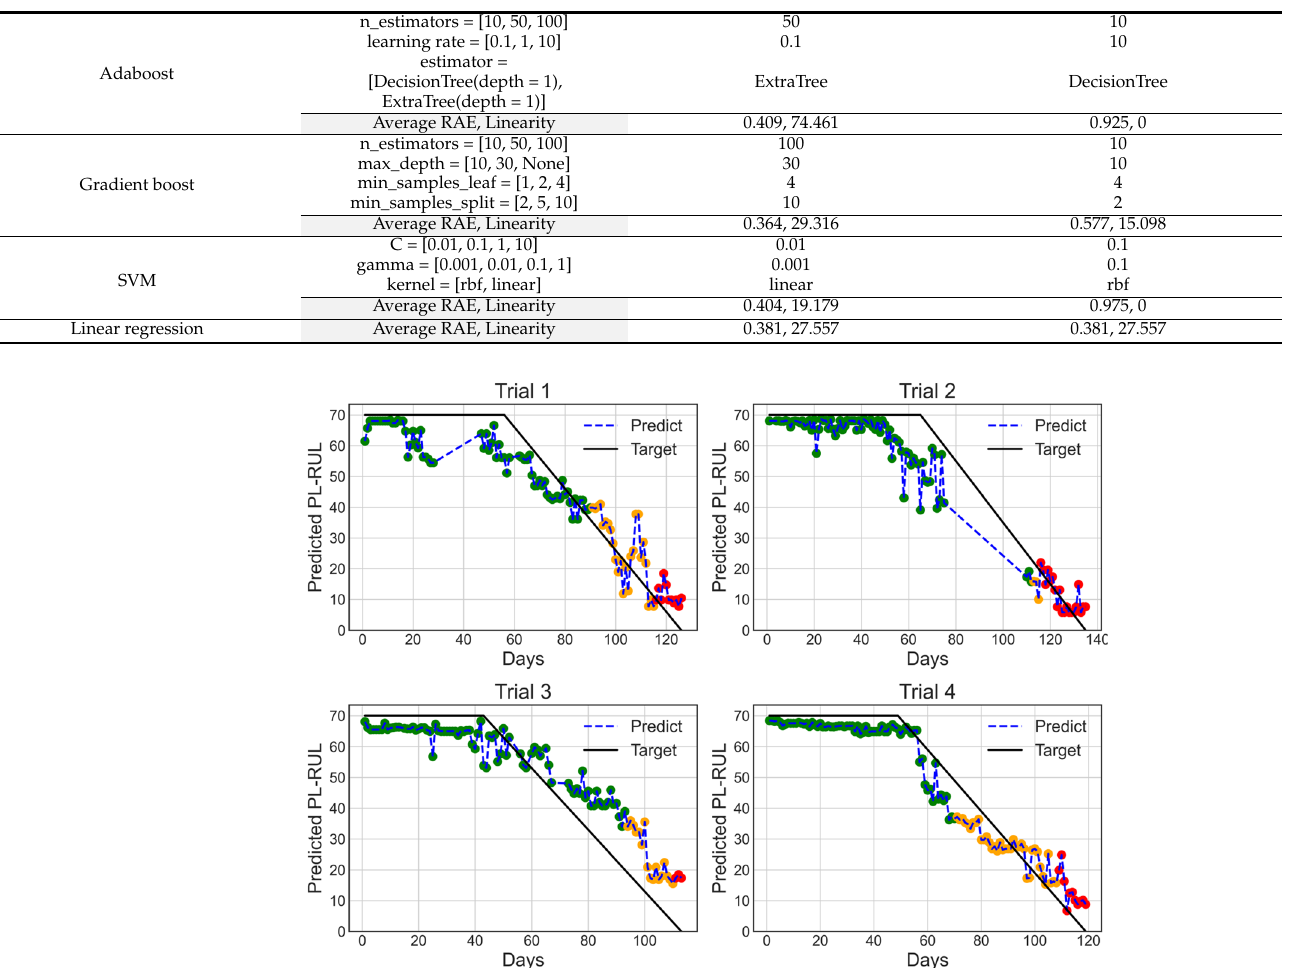
Figure 8. 4-fold cross-validation results with T RUL = 70 days for trials 1 to 4 using A/C dataset and XGBoosting regressor with optimal regressor settings (min_child_weight = 10, gamma = 1.5, n_estimators = 50, colsample_bytree = 0.6, max_depth = 4).